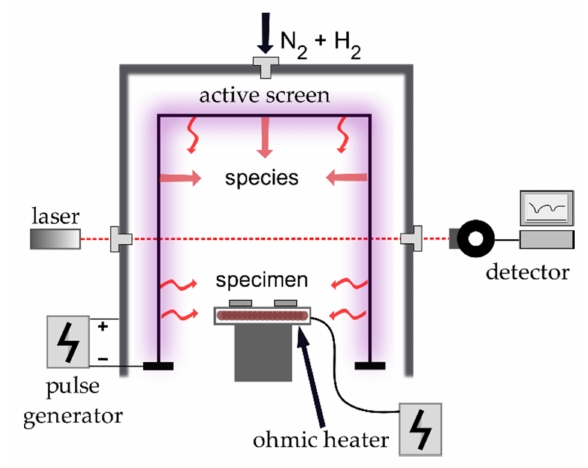
Figure 1. Schematic illustration of the experimental setup of active screen plasma nitrocarburizing (ASPNC) reactor and newly introduced ohmic